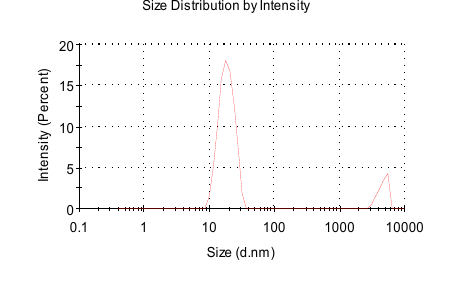
Distribution by Intensity